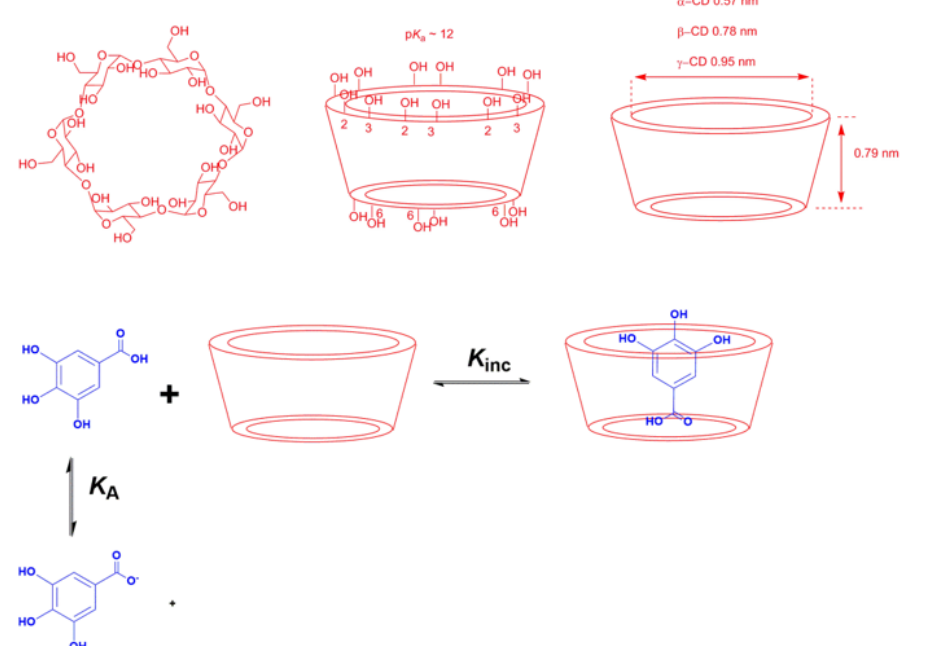
Figure 7. Chemical structures of the natural CDs showing the spatial conformation, the location of primary and secondary –OH groups and the size of their cavities, and an illustrative representation of an inclusion complex between a gallic acid derivative and cyclodextrins (CDs) [53]. The inclusion of antioxidants in a CD cavity can be rationalized in terms of the substitution of the water molecules included in the cavity by the somewhat hydrophobic antioxidant. The host–guest complexes are non-covalent because no covalent bonds are formed or broken during their formation, being the driving forces for the inclusion process in hydrophobic interactions, hydrogen bonds and Van der Waals interactions [54,55]. Antioxidants, however, may readily dissociate in aqueous solution, and the equilibrium between free antioxidant molecules and hosted antioxidants is rapidly established. The formation of CD complexes is, thus, a dynamic equilibrium process [56] that can be described by Equation (9), where m and n are the stoichiometric coefficients, CD is the cyclodextrin, AO is the guest molecule (in this work, an antioxidant) and AO-CD is the inclusion complex, respectively. The most typical stoichiometry is 1:1, but 1:2, 2:1 or